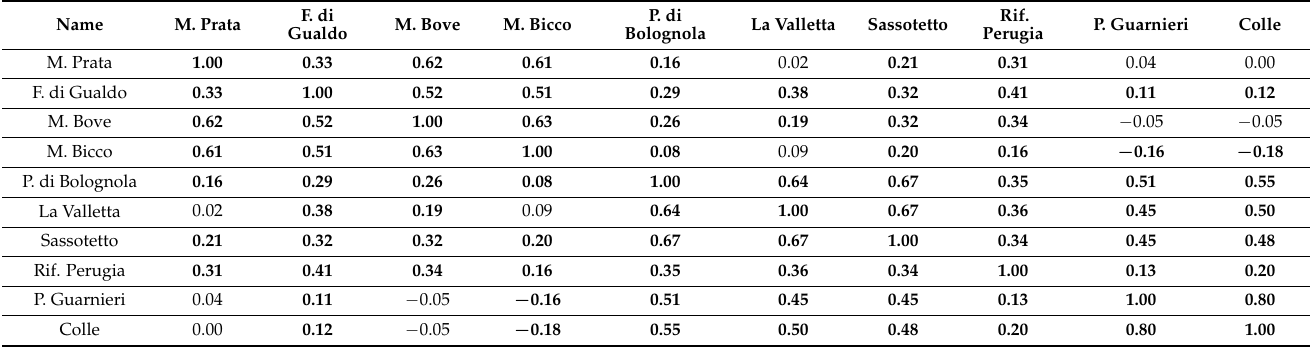
Table 3. Correlation matrix performed with Kendall’s tau method between weather stations for daily snow depth data; the stations with a significant 95% correlation between them are in